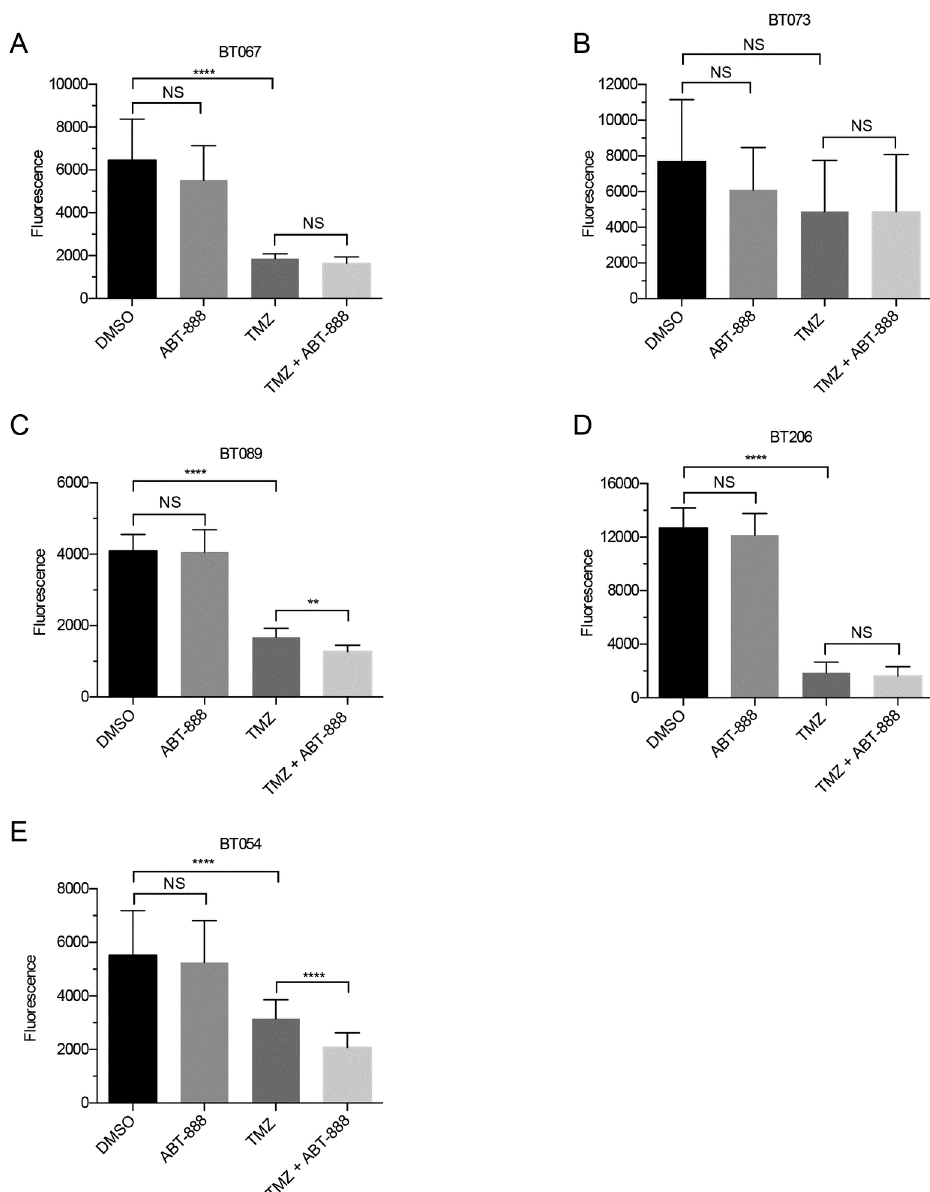
Fig 1. Average viability of Group I BTICs (n = 3, ± standard deviation or SD). Lines were treated with DMSO, ABT-888 (10 μM), TMZ (50 μM), or the combination of TMZ (50 μM) and ABT-888 (10 μM). Eight days after treatment cell viability was inferred using the alamarBlue 1 assay. The unpaired t-test was applied to assess differences, as shown. Viability was unaffected by ABT-888 alone, whereas TMZ decreased viability in all lines but BT073 (B). The combination decreased viability in two of five BTICs (ns = p > 0.05; (cid:3)(cid:3) = p < 0.01; (cid:3)(cid:3)(cid:3)(cid:3) = p < 0.0001).